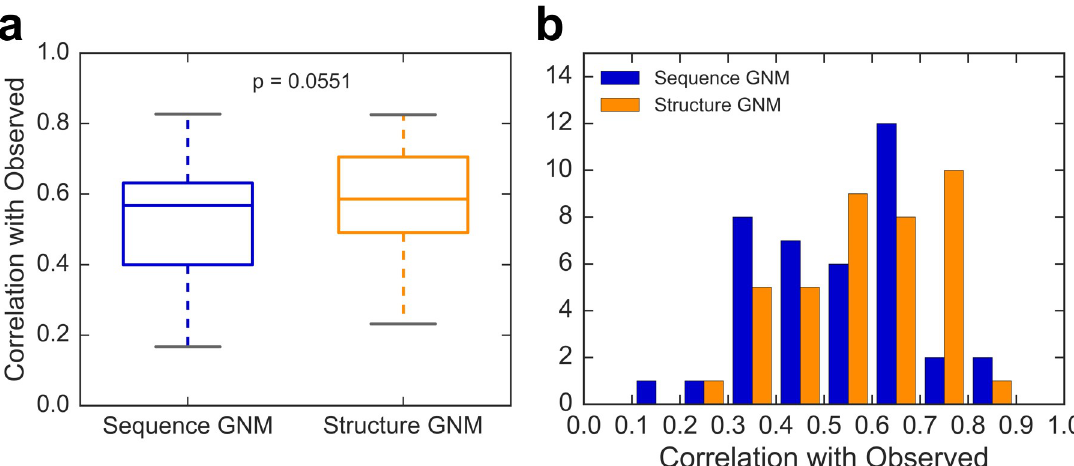
Fig 3. Comparison of B-factors obtained by GNM and Seq-GNM with experimental B-factors. (a) Boxplot showing the correlation of predicted B-factors by the Seq-GNM with experimentally observed B-factors (blue) in comparison to that of the GNM obtained from structure (orange) for a subset of 39 structures with resolution better than 2.0 Å . (b) A distribution plot of the same correlations binned into 10 bins with sizes of 0.1. A student t-test reveals no significant difference between the two distributions (p = 0.055) indicating that the Seq-GNM is producing competitive results compared to the original GNM from structure. The mean correlation of the Seq-GNM is 0.53 while that of the GNM from structure is